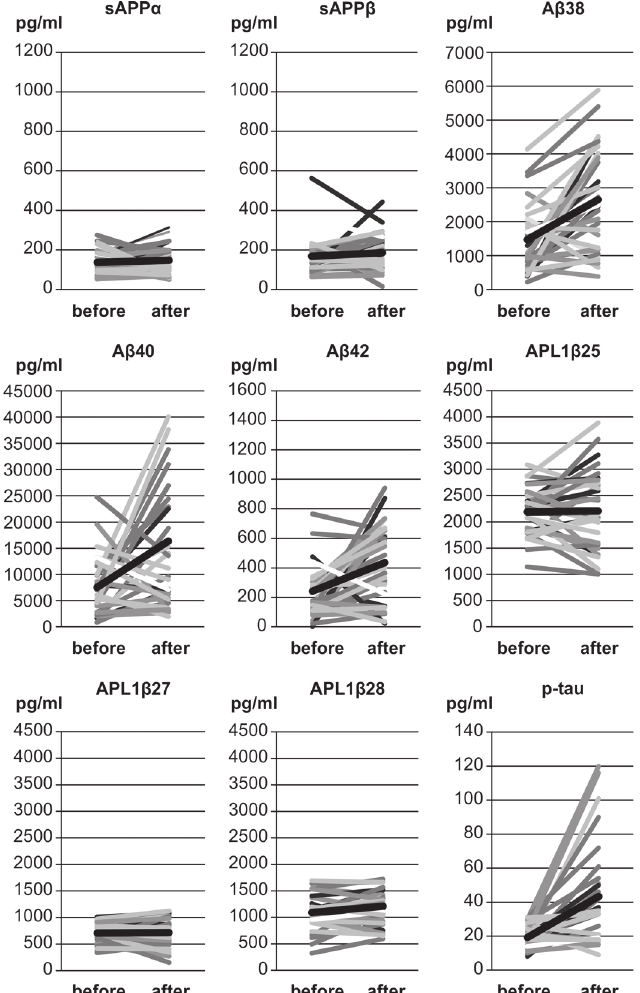
Fig 3. Graph showing the relation between pre- and post-operative lumbar CSF values of individual patients with iNPH for sAPP α , sAPP β , A β 38, 40, and 42, APL1 β 25, 27, and 28, and p-tau. Abbreviations: CSF, cerebrospinal fluid; iNPH, idiopathic normal pressure hydrocephalus; before, before lumboperitoneal shunt; after, 1 year after lumboperitoneal shunt; sAPP, soluble amyloid precursor protein; A β , amyloid β - peptide; APL1 β , APLP1-derived A β like peptide; p-tau, tau phosphorylated at threonine 181.